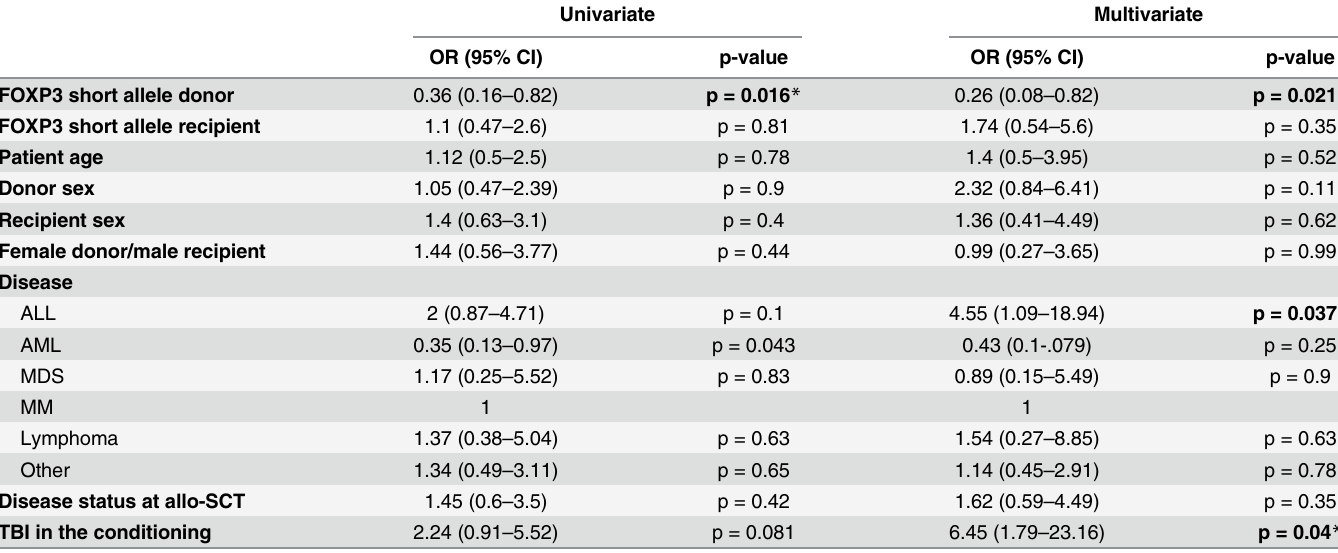
Table 3. Univariate and multivariate analysis for variables potentially associated with the development of grade III-IV aGvHD. Univariate Multivariate OR (95% CI) p-value OR (95% CI)